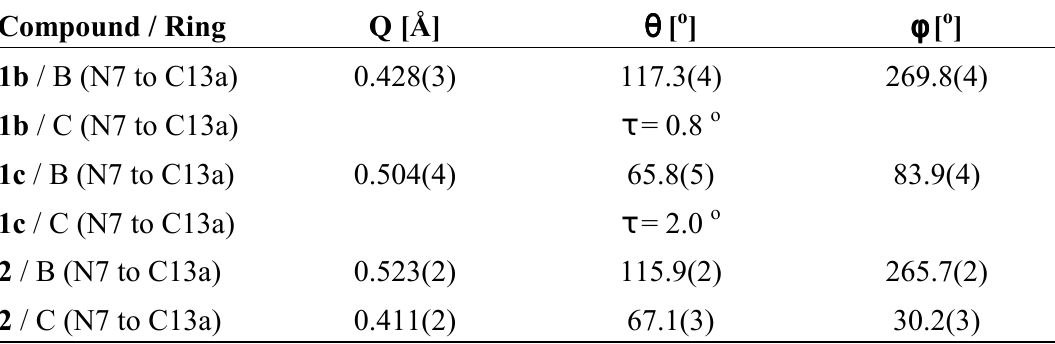
Table 3. Puckering parameters of the compounds 1b , 1c , and